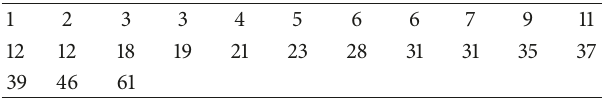
Table 9: Results of AIC and AICc criteria and the 𝑝 value from the KS test for all fitted distributions considering the Pricker B. Criteria